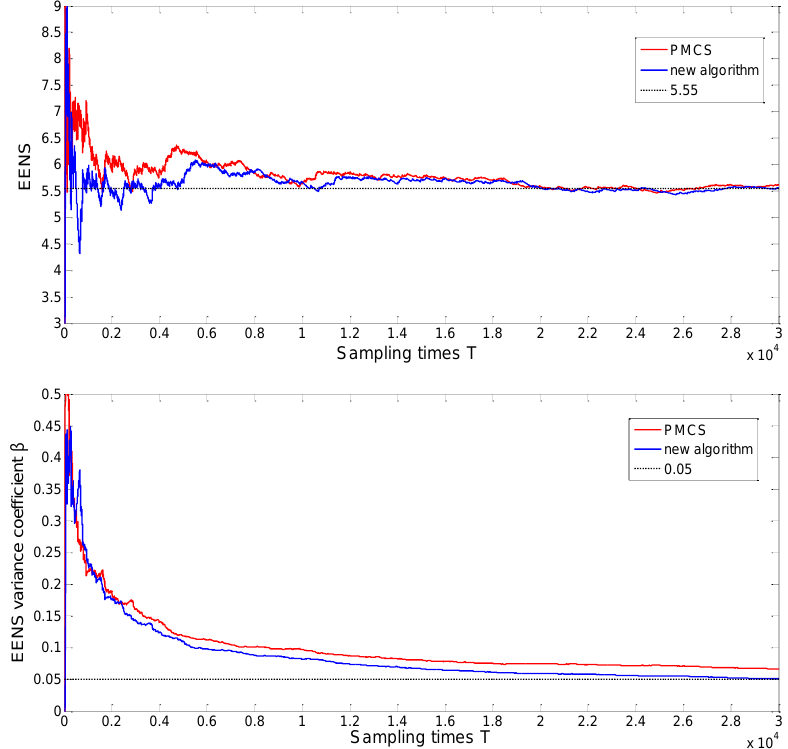
Figure 9. Convergence process of the expected energy not supplied (EENS) index in different algorithms. Table 2. Comparison of indices with different algorithms.